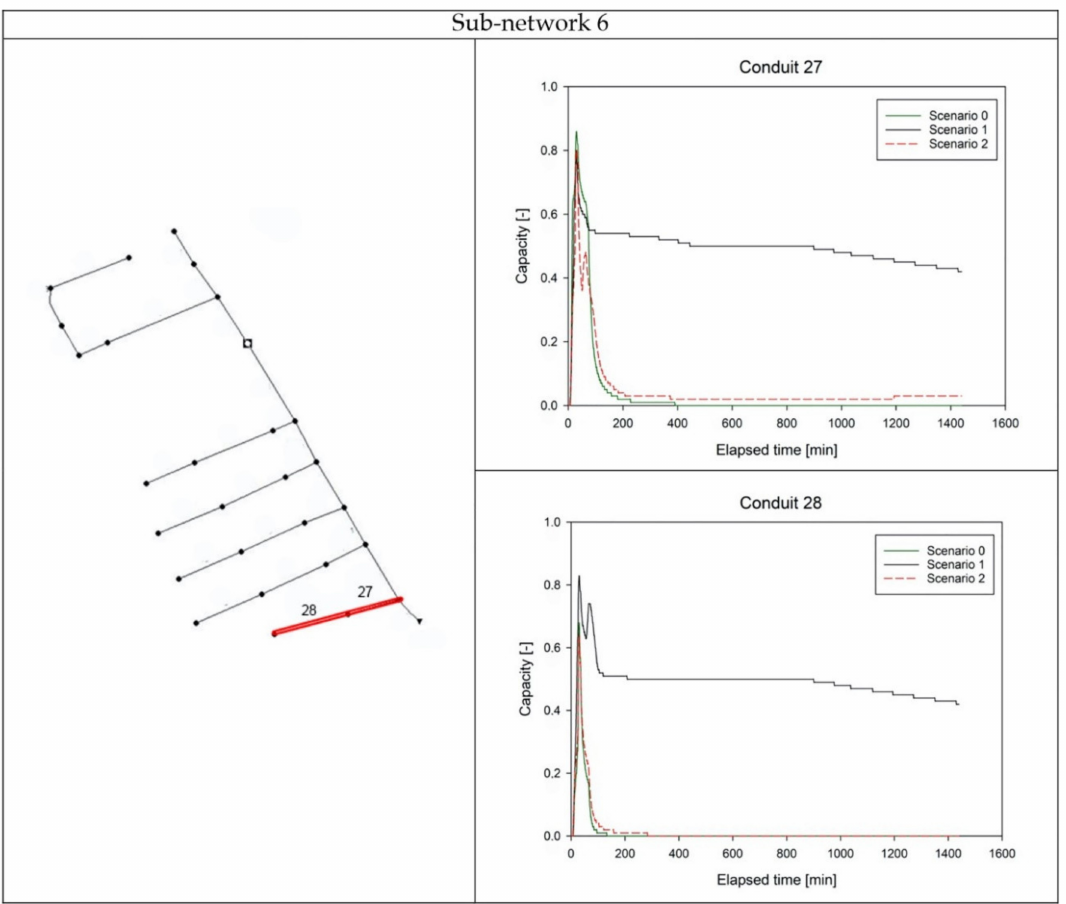
Figure A8. Conduits’ capacity in sub-network 6, highlighted in red in the first picture where the drainage network schematization is